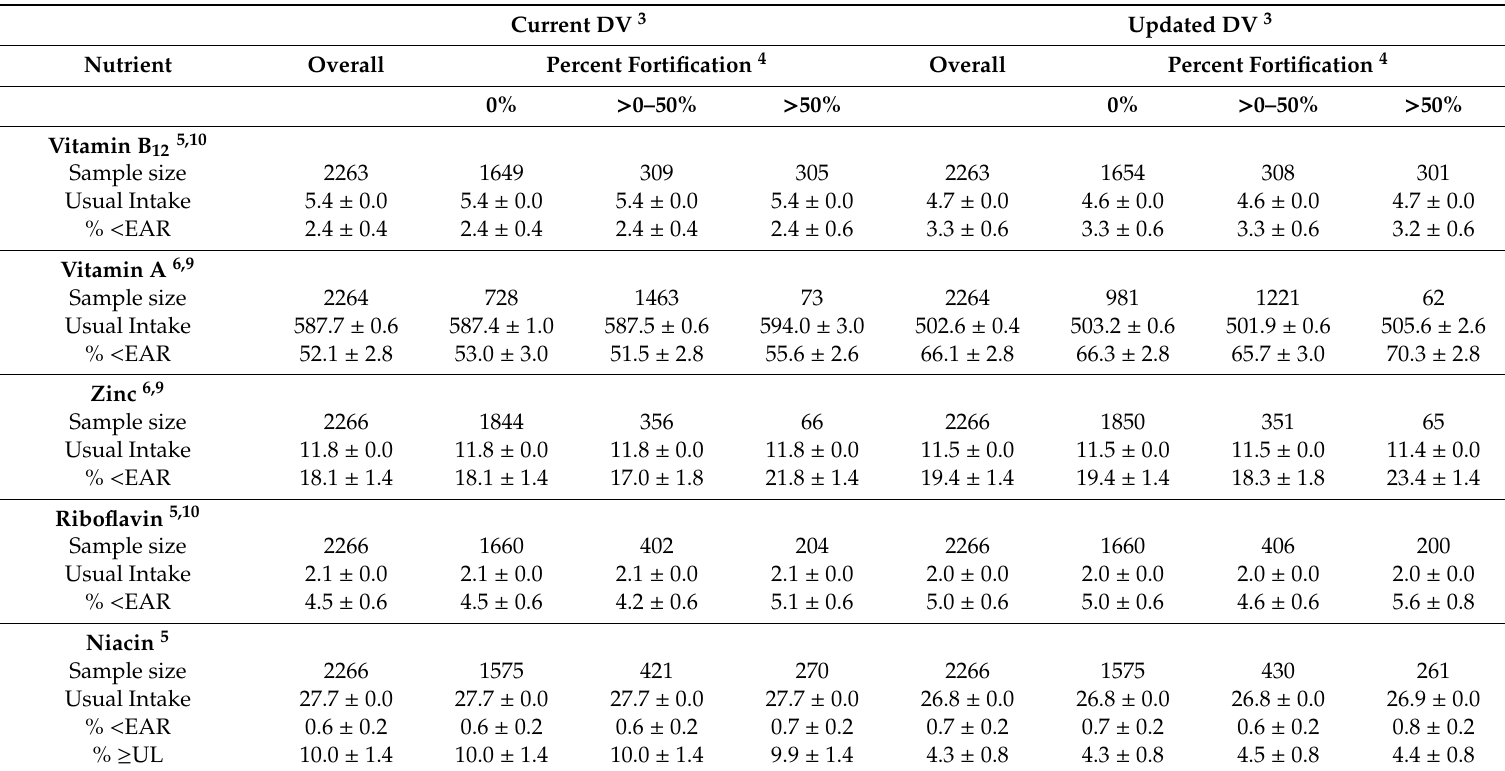
Table A2. Comparison of Current Daily Value (DV) and Updated DV nutrient intake models with overall and percent fortification subgroups for US adults (19–30 years of age) (Mean ± SEM) 1,2